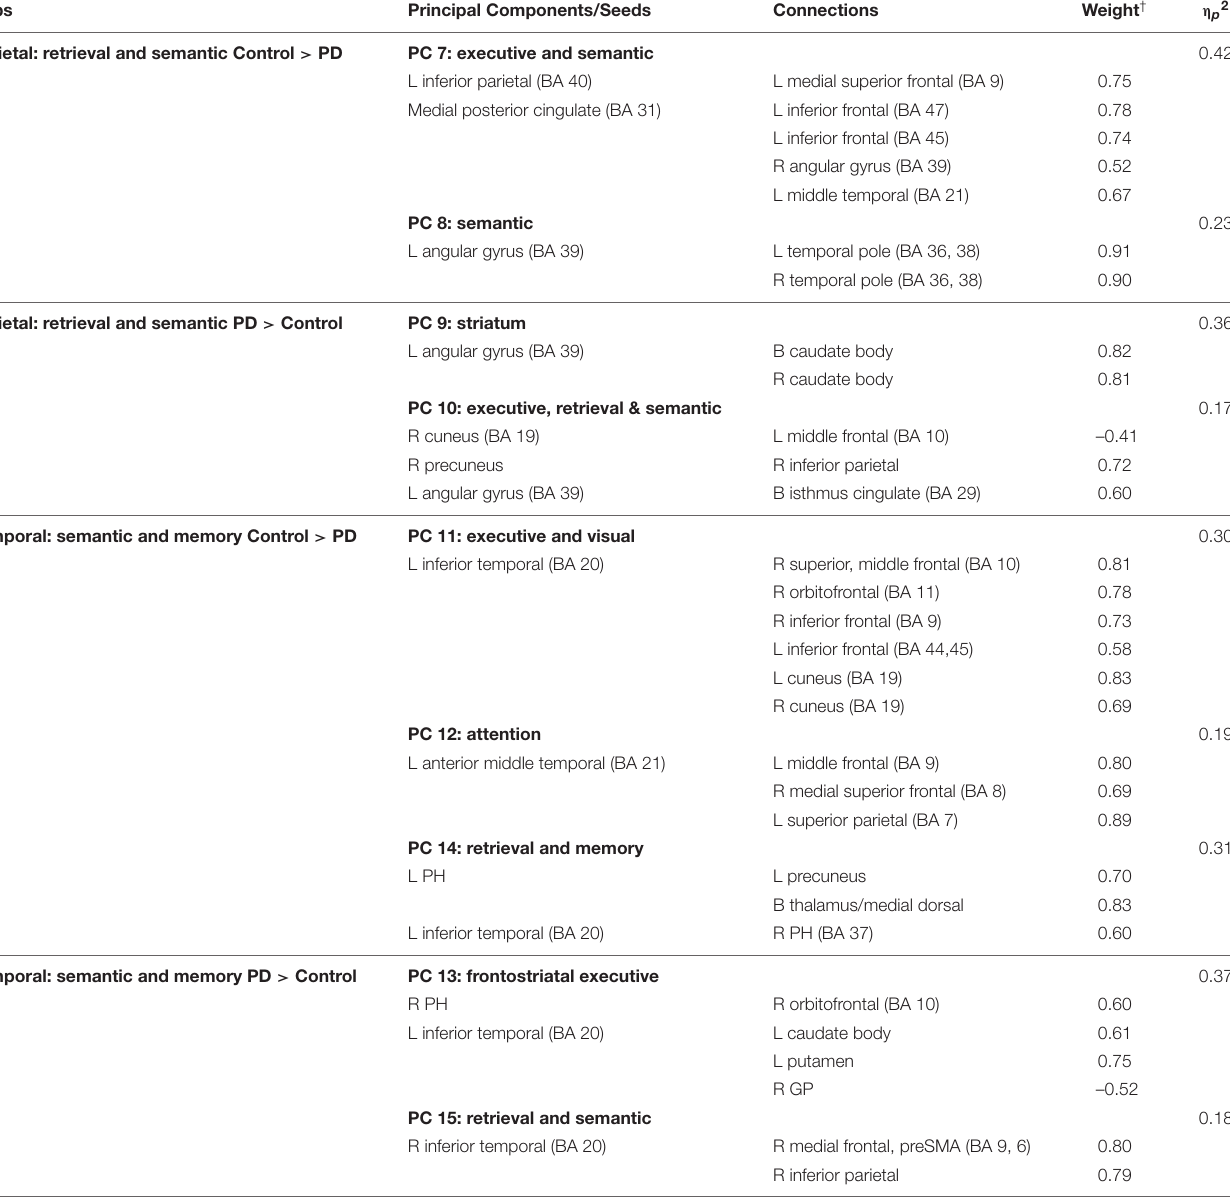
TABLE 4 | Principal components characterizing fame-modulated couplings of posterior cortical regions of interest.